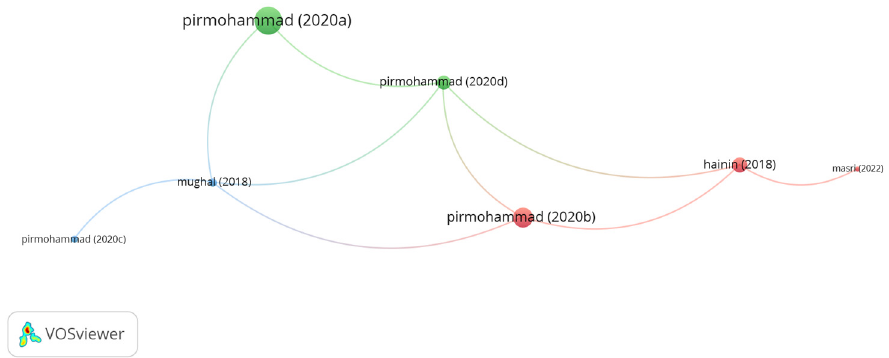
Figure 17. Network visualization of kenaf fibers.